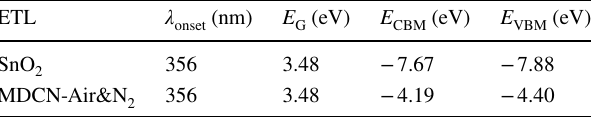
Table 3 Summary of the energy‑level parameters for various